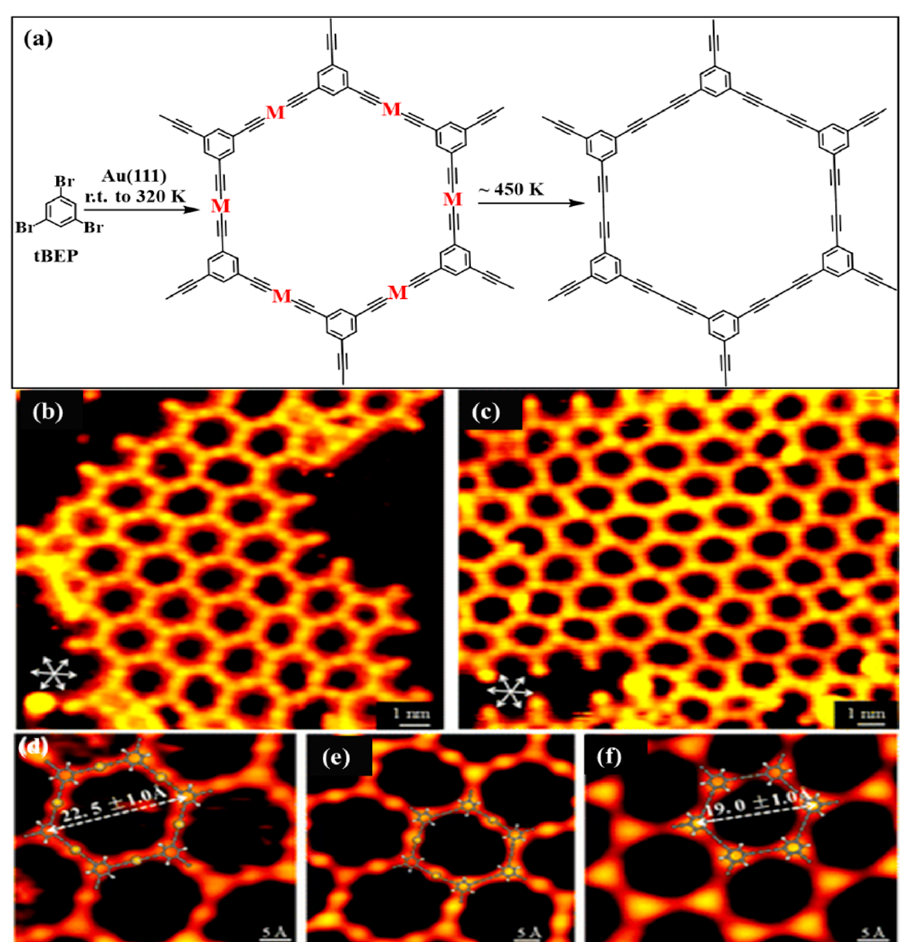
Figure 7. Schematic representation of the growth of the organometallic framework after the deposition of tribromophenyl on Au(111) surface (from RT to 320 K) and the formation of GDY after heat treatment at 450 K ( a ). Scanning tunneling microscopy micrograph revealing the creation of GDY before and after heat treatment at 450 K ( b , c ). Detailed STM pictures of the C–Au–C framework ( d ), the mixture of C–Au–C networks and GDY fragments ( e ), and the GDY layer ( f ). The modeled structures of all considered networks are superimposed on the STM micrographs. Reproduced with permission [80]. Copyright 2016, American Chemical Society.